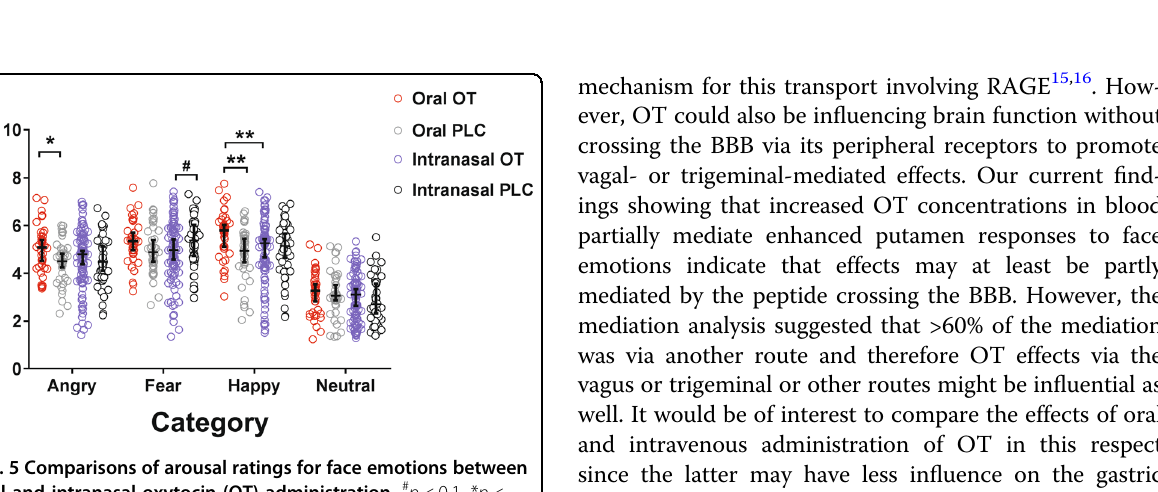
Fig. 4 Region of interest (ROI) analysis comparing effects of oral and intranasal oxytocin (OT) on amygdala and putamen responses. A right amygdala mask from the Brainnetome Atlas. B Oral OT signi fi cantly increased activation of the right amygdala, while intranasal oxytocin decreased it. C Right putamen mask from Brainnetome Atlas D oral oxytocin increased the activation of right putamen to all face emotions but intranasal OT had no effect. PLC placebo. * p FDR < 0.05, ** p FDR < 0.01.